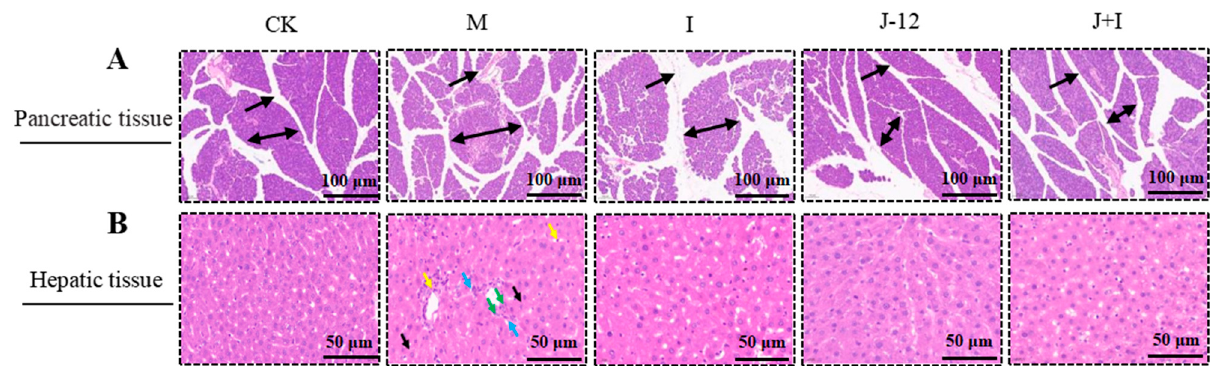
Figure 4. J-12 reduced pancreatic and hepatic tissue damage in rats with hyperglycemia in pregnancy. ( A ) H&E staining in pancreatic sections. Islet cells are indicated by the double arrow, and interlobular catheter are indicated by the single arrow. Magnification = × 100. Scale bar: 100 µ m. ( B ) H&E staining in hepatic sections. Liver cells are indicated by the black arrow, inflammatory cells are indicated by the yellow arrow, fibrous connective tissue cells are indicated by the blue arrow, and bile duct cells are indicated by the green arrow. CK: control group, rats fed a standard diet. M: model group, rats fed an HFD and administered a single STZ injection prior to pregnancy and then fed a standard diet during pregnancy. I: insulin group, rats fed an HFD and administered a single STZ injection prior to pregnancy and then fed a standard diet and injected with insulin during pregnancy. J-12: J-12 group, rats fed an HFD and administered a single STZ injection prior to pregnancy, then, fed a standard diet during pregnancy. Rats administered the J-12 suspension (1 × 10 9 CFU daily) by gavage during the entire experimental period. J + I: J-12 plus insulin group, rats fed an HFD and administered a single STZ injection prior to pregnancy, then, fed a standard diet and injected the insulin and during pregnancy. Rats administered the J-12 suspension (1 × 10 9 CFU daily) by gavage during the entire experimental period. Magnification = × 400. Scale bar: 50 µ m. Table 2. Effect of J-12 on physiologic parameters of